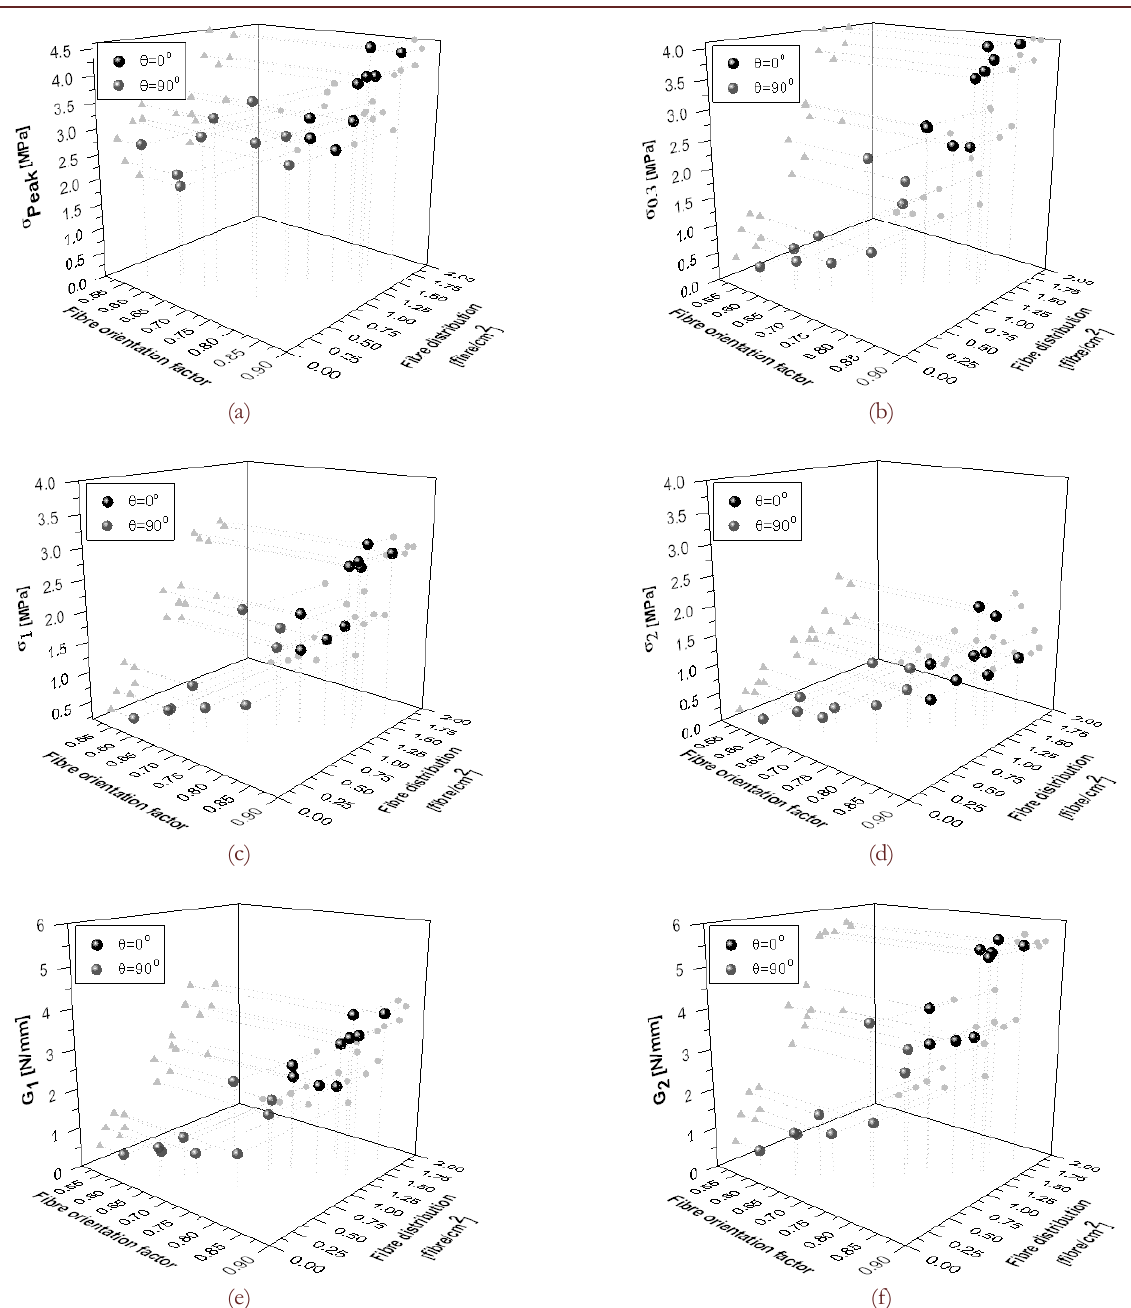
Figure 16: Relationship between the fibre distribution, the fibre orientation factor and the post-cracking parameters: (a) peak stress, (b), (c) and (d) stress at a 0.3, 1 and 2 mm crack width, respectively; (e) and (f) energy absorption up to 1 and 2 mm crack width,